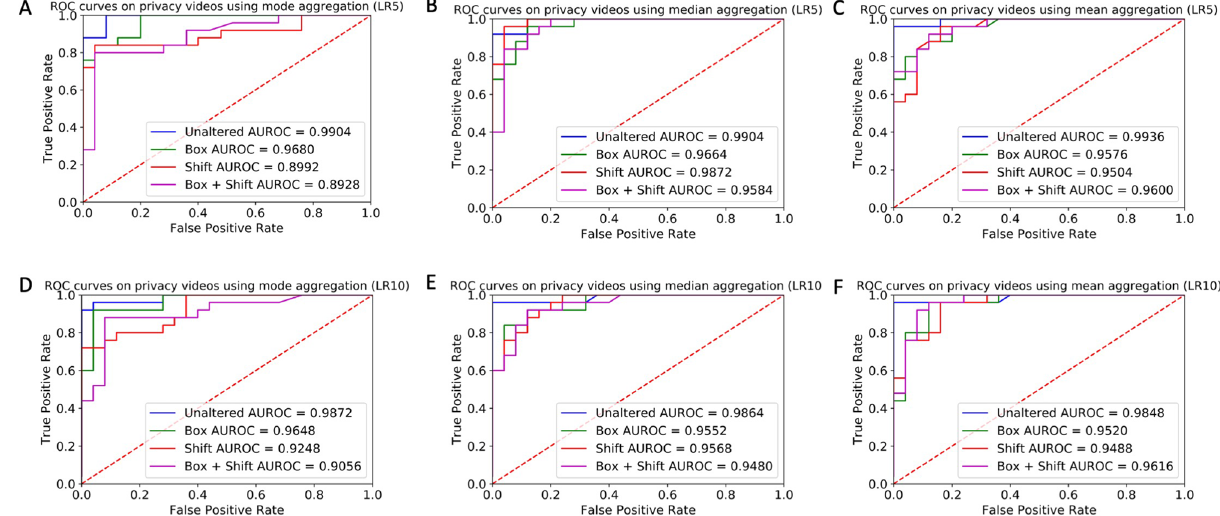
Figure 3. ROC curves of the classifiers trained on aggregated features from the filtered crowd raters under each privacy condition. The true positive rate is plotted against the false positive rate for different class cutoffs of the logistic regression classifier’s output probability. The color of the curve represents the privacy condition: blue represents unaltered videos, green represents face obfuscation, red represents pitch shift, and purple represents face obfuscation and pitch shift. Plots show aggregated results using the ( A , D ) mode, ( B , E ) median, and ( C , F ) round of the mean of the crowd worker responses. The ROC curves are shown for both the LR5 ( A – C ) and LR10 ( D – F ) classifiers. Area under the curves increasingly closer to 1.0 indicate increasingly better performance, and a value of 0.5 indicates random guessing by the